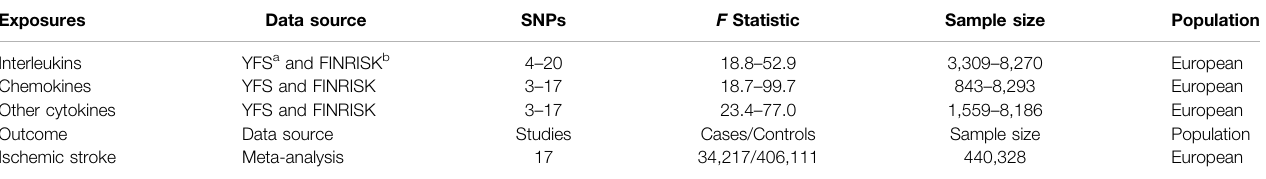
TABLE 1 | Characteristics of in fl ammatory cytokines and ischemic stroke